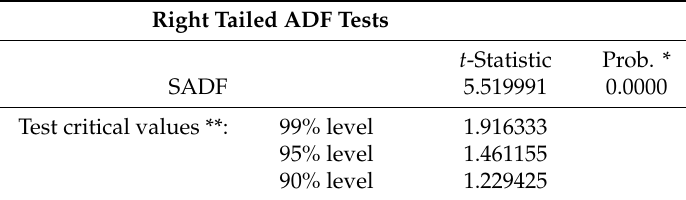
Table 3. Supremum Augmented Dickey–Fuller (SADF) results for CEI.